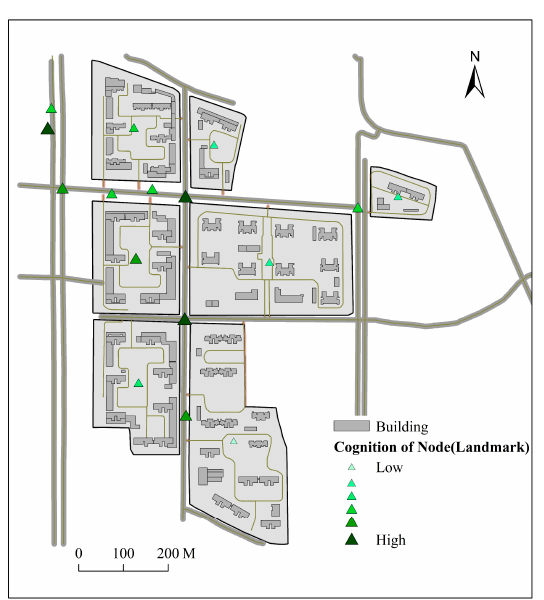
Figure 10. The cognitive results of the node (landmark) elements.